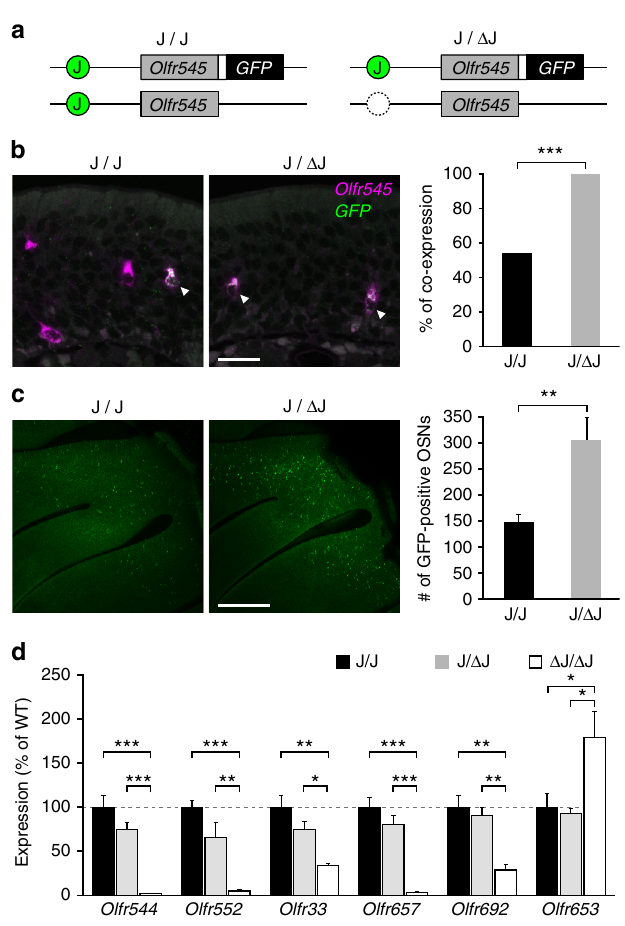
Fig. 5 Deletion of the trans J element increases expression frequency from the intact J allele. a Schematic illustrations of the Olfr545 alleles of mice used in b and c . One allele contains the intact J element and tauGFP-tagged Olfr545 , and another allele contains the intact or deleted J element and untagged Olfr545 . The white box represents the IRES sequence. b Confocal images of two-color ISH for Olfr545 ( magenta ) and GFP ( green ). The bar graph shows the percentage of co-labeled cells: 124 co-labeled cells and 107 Olfr545 single-positive cells in J/J (54,3%, from 3 mice), 213 co-labeled cells and no Olfr545 single-positive cells in J/ Δ J mouse (100%, from 3 mice). The intact J element of the GFP-tagged wild-type allele did not rescue the defective phenotype of Olfr545 expression from the mutant allele. The scale bar is 20 μ m. Fisher ’ s exact test; p < 2.2 × 10 − 16 , *** p < 0.001. c Whole-mount confocal images of the turbinate. The bar graph shows the numbers of GFP-positive OSNs on the medial face of the turbinate in half-head. The number of GFP-labeled OSNs of J/ Δ J is ~ 2 times larger than in J/J mice. The error bars represent the mean ± s.e.m. ( n = 6 for J/J, n = 5 for J/ Δ J). The scale bar is 500 μ m. Unpaired t -test, p = 0.0046, ** p < 0.01. d Percentage of OSNs expressing class I genes in Δ J heterozygous (J/ Δ J) or homozygous ( Δ J/ Δ J) mice compared to wild- type (J/J, set as 100%). The error bars represent the mean ± s.e.m. ( n ≥ 4). One-way ANOVA in each Olfr probes. Tukey ’ s post hoc multiple comparisons test shows signi fi cant difference between